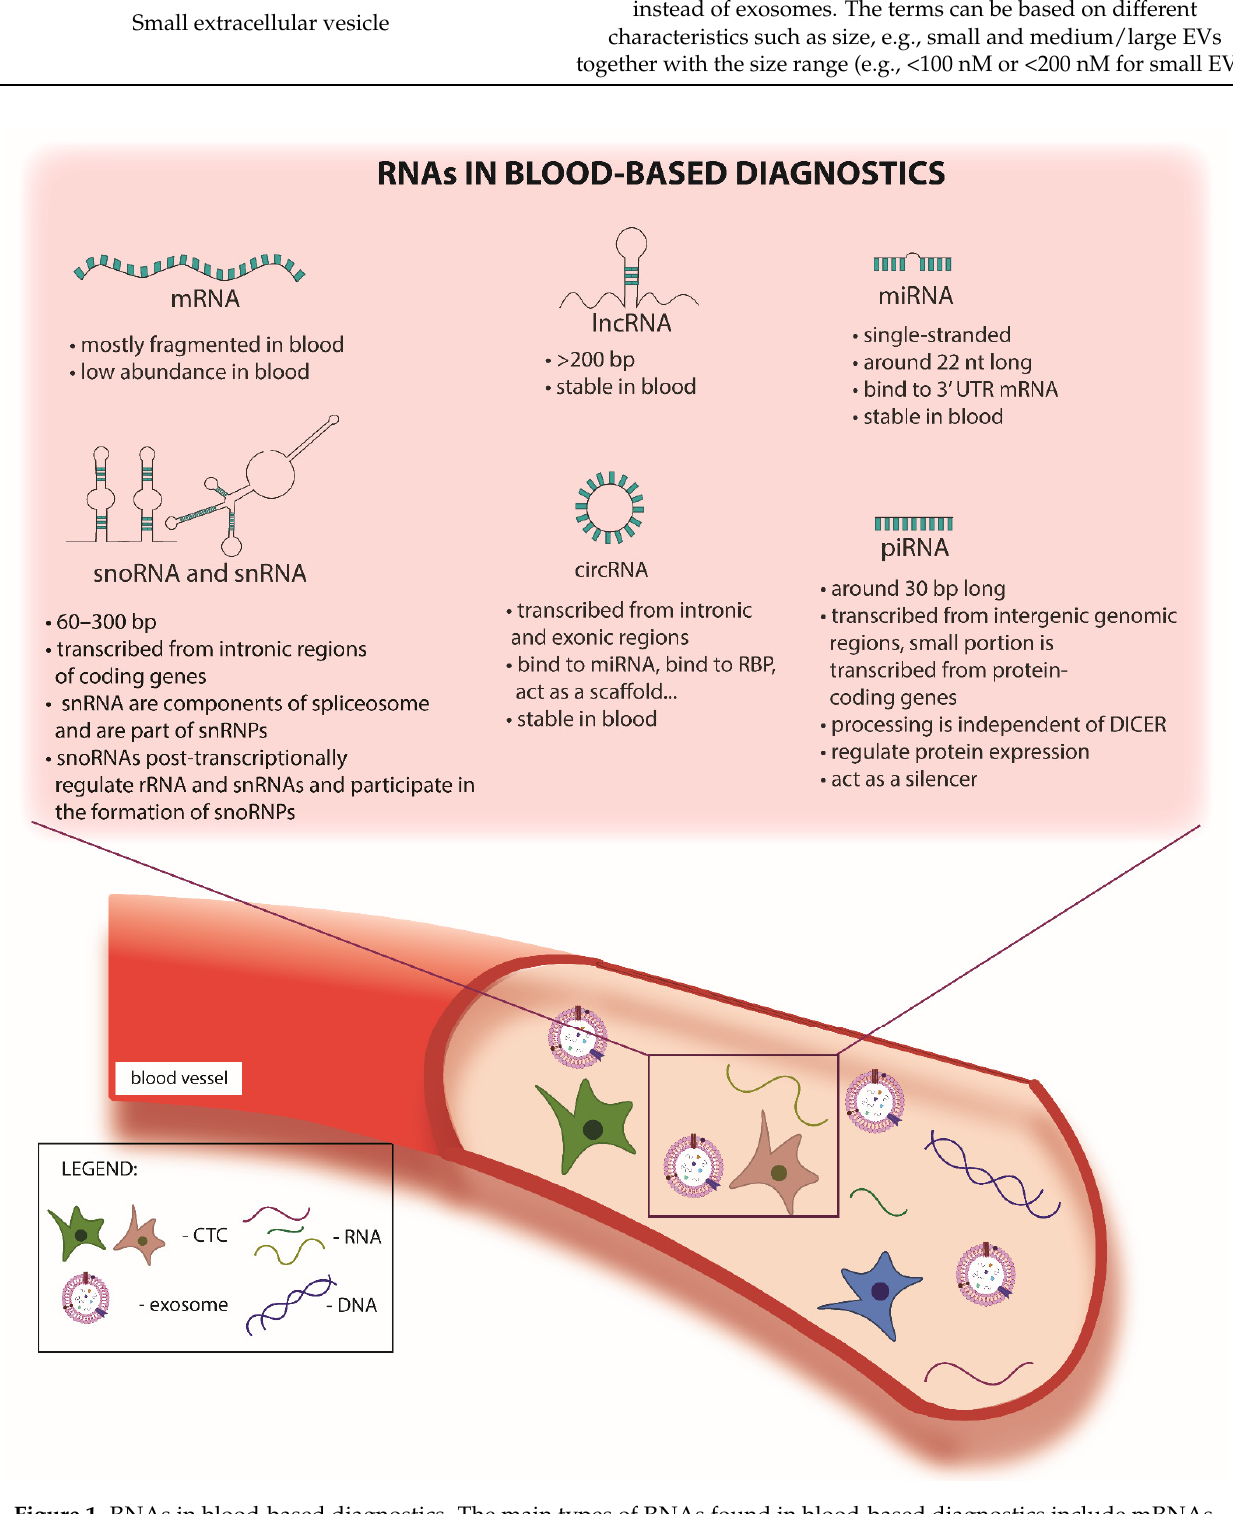
Figure 1. RNAs in blood-based diagnostics. The main types of RNAs found in blood-based diagnostics include mRNAs, long non-coding RNAs, microRNAs, small nucleolar RNAs, small nuclear RNAs, circular RNAs and piwi-interacting RNAs. Additional markers in blood cancer tumour cells, ct-DNAs, CTCs and exosomes amongst others can be found.